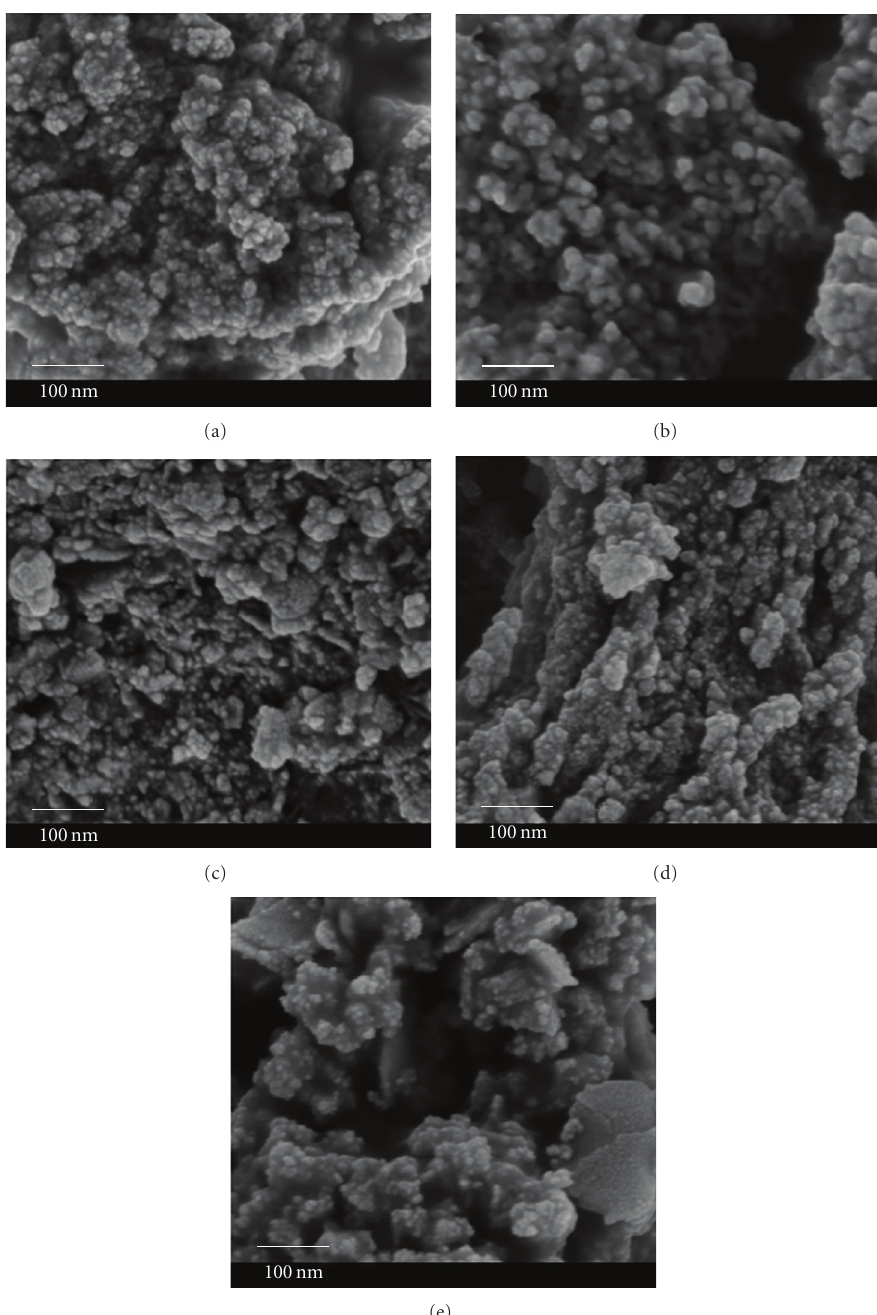
Figure 6: SEM images of the typical morphology and composition of pure (a), 5, 10, 33.3, and 50 % Ni doped ((b), (c), (d), and (f), resp.) SnO 2 nanoparticles. Table 3: NiO/SnO 2 atomic % ratio of the produced samples measured by EDX Technique at three areas. NiO/SnO 2 molar